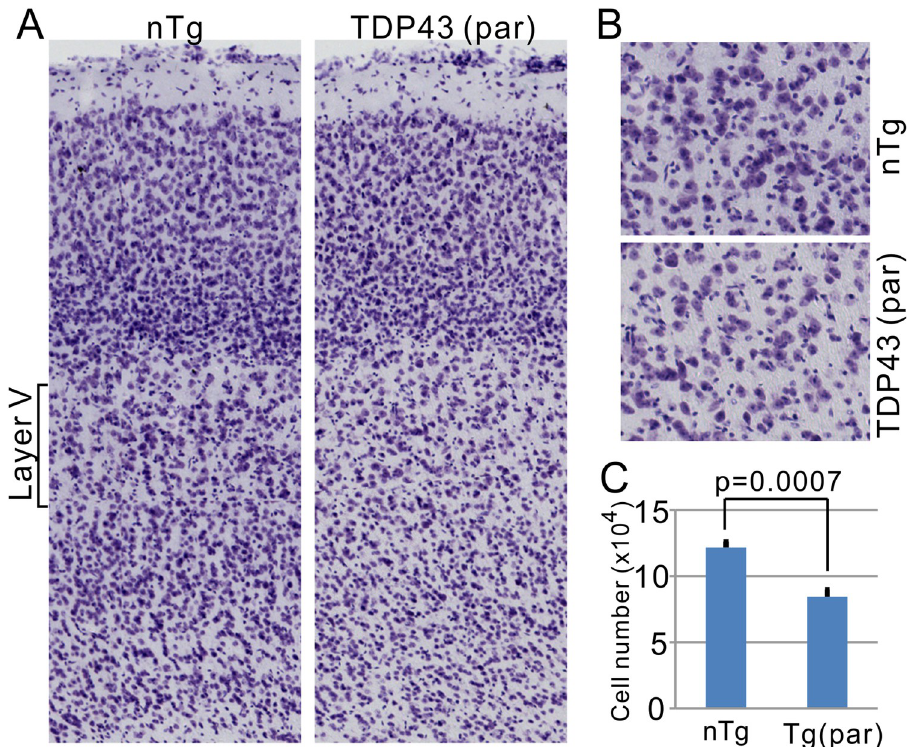
Fig 13. Visualization and quantification of Nissl-stained neurons in the motor cortex. (A) Nissl-stained motor cortex in nTg and paralyzed Tg mice. (B) Enlarged views of layer V motor cortex. (C) quantification of large ( > 15 μ m in diameter) Nissl-stained neurons in layer V. P value was derived from Student’s t test. n = 4 for nTg and 3 for Tg mice.